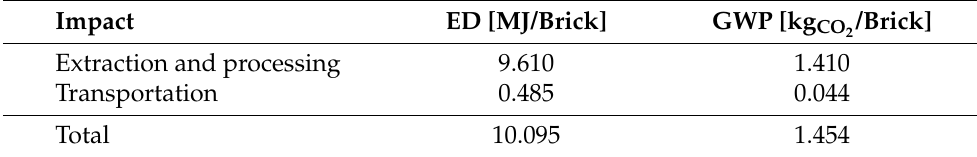
Table 9. Average ED and GWP related to the extraction, processing and transportation for the BMS of one